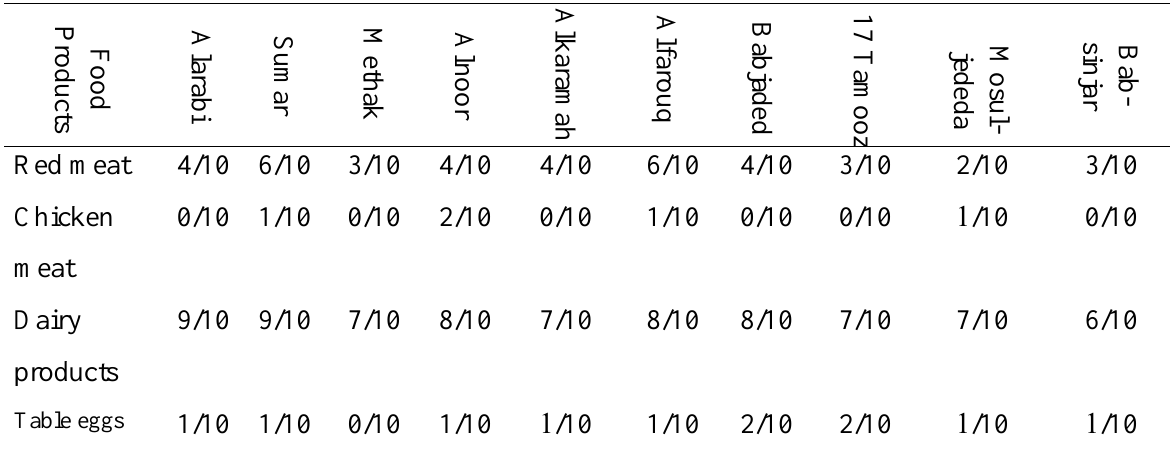
Table 4: Number of food products of animal origin displayed at freezing temperature: